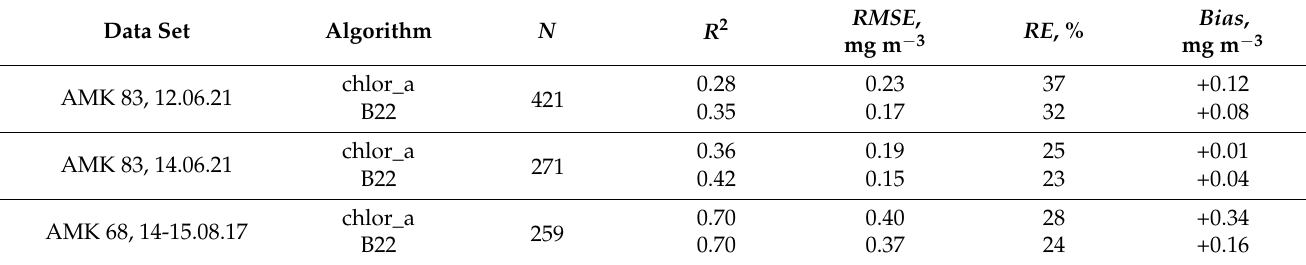
Table 2. The correspondence parameters between the values of chlorophyll concentration meas- ured with a fluorimeter and calculated based on MODIS data by standard and regional algo- rithms, depending on the data set.